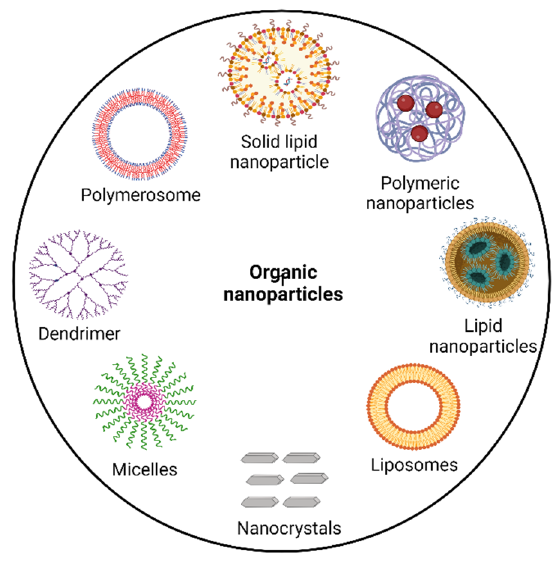
Figure 1. Important types of organic nanoparticles.